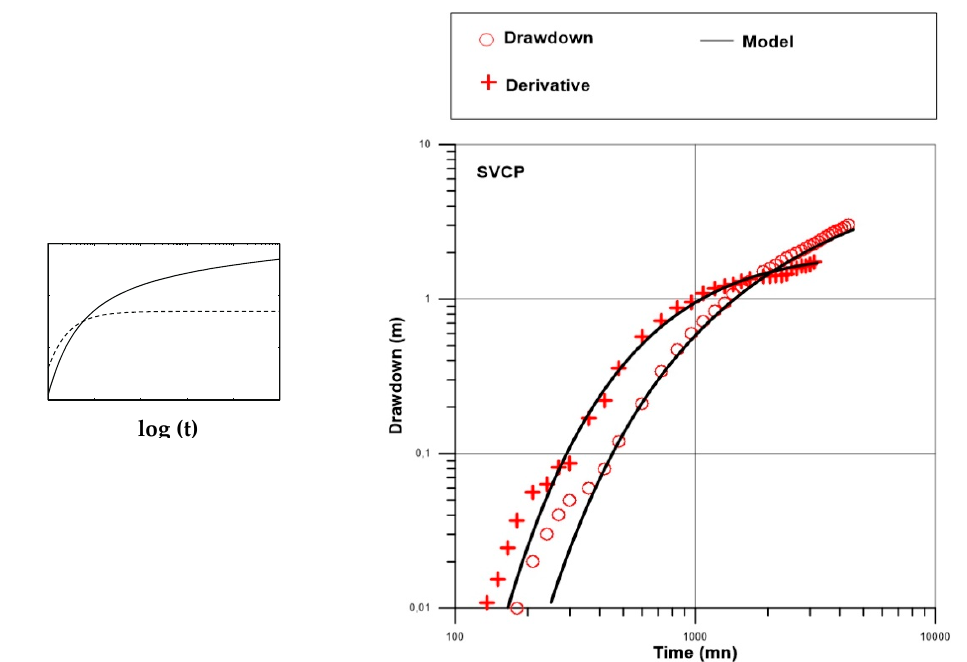
Figure 15. Interpretation of pumping test SVCF/SVCP: diagnostic plot ( left ) and data superimposed with a fitted Theis model ( right ).